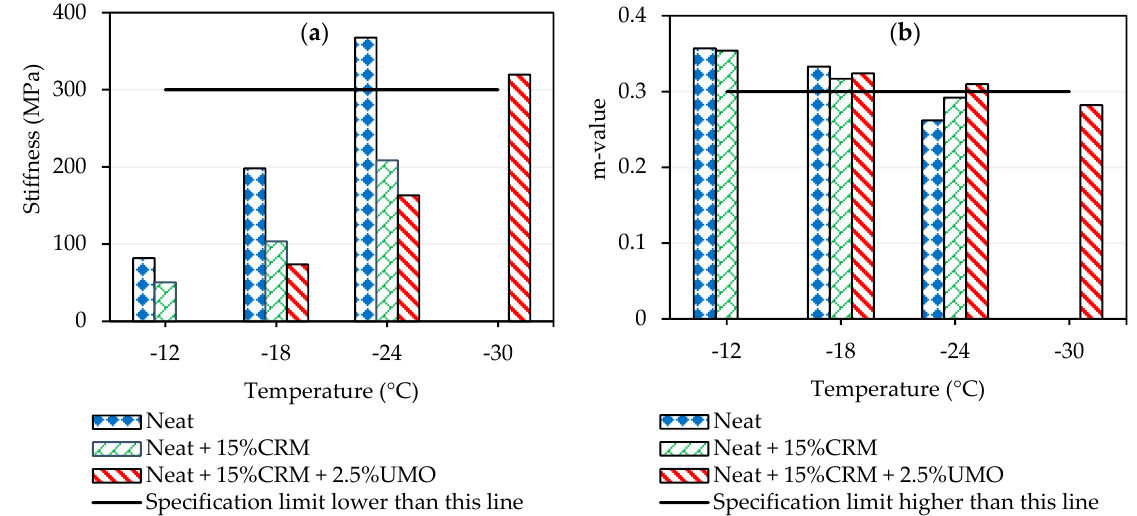
Figure 4. BBR test results: ( a ) BBR stiffness; ( b ) BBR m-value, measured for PG 52-28 neat and modified asphalt binder samples interacted at 170 °C—50 Hz—75 min.